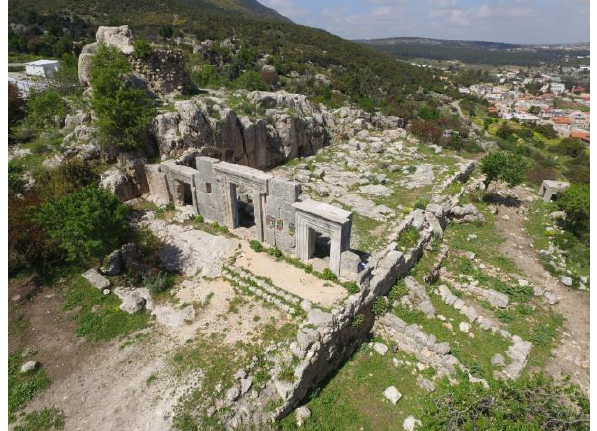
Figure 6. Meron synagogue, type E. (Photo: G. Pitusi, 2016 © IAA)